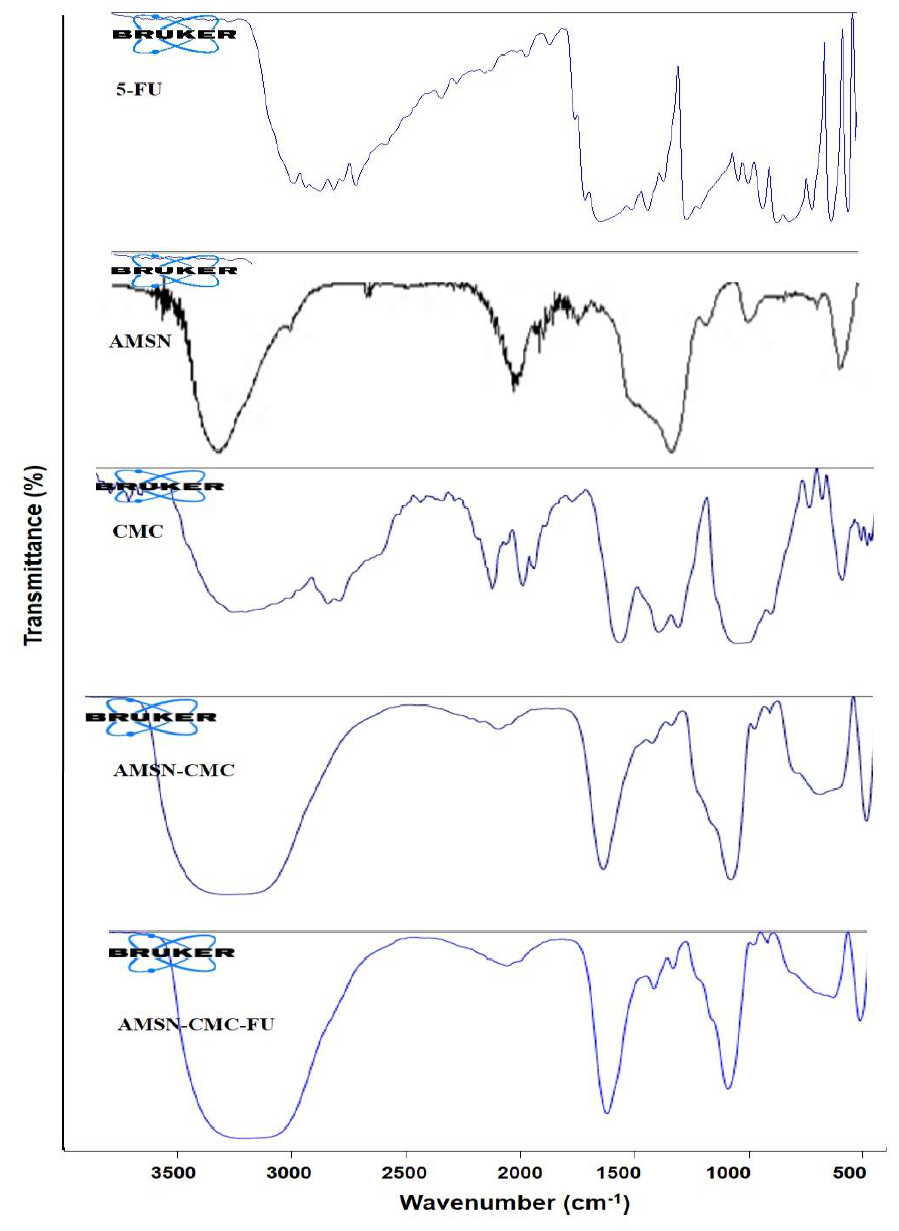
Figure 6. FTIR spectra of 5-FU, AMSN, CMC, AMSN − CMC, and AMSN − CMC − FU.